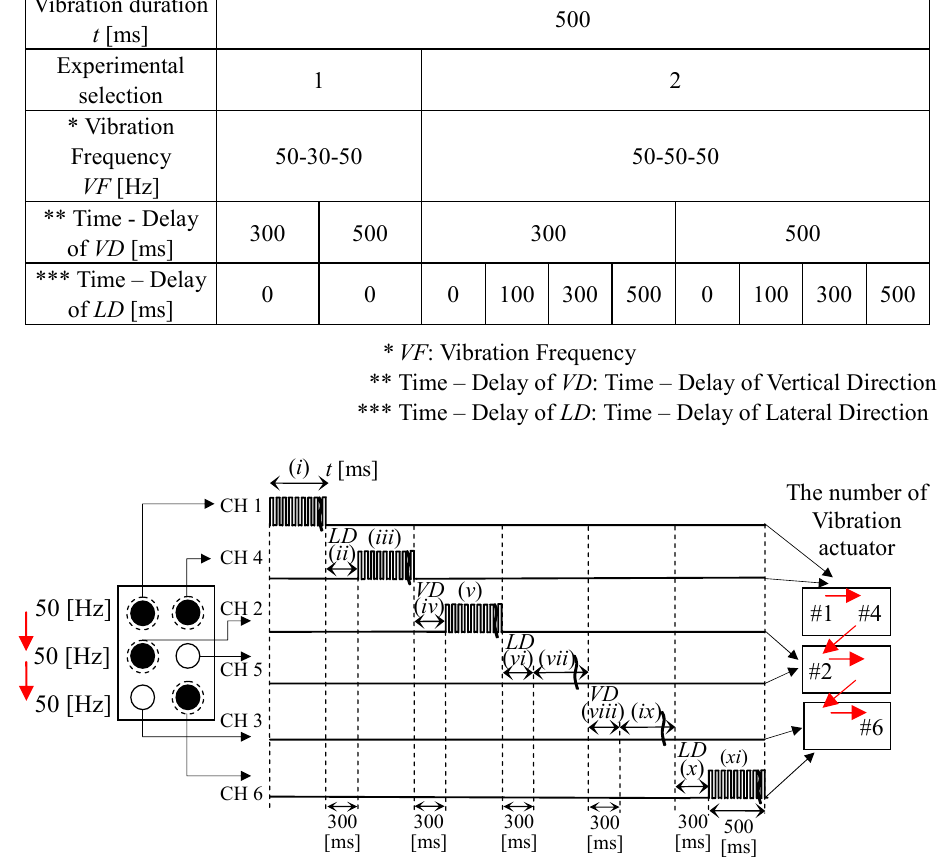
Fig.15 Vibration actuator Driving of Six-stage mode / ke /